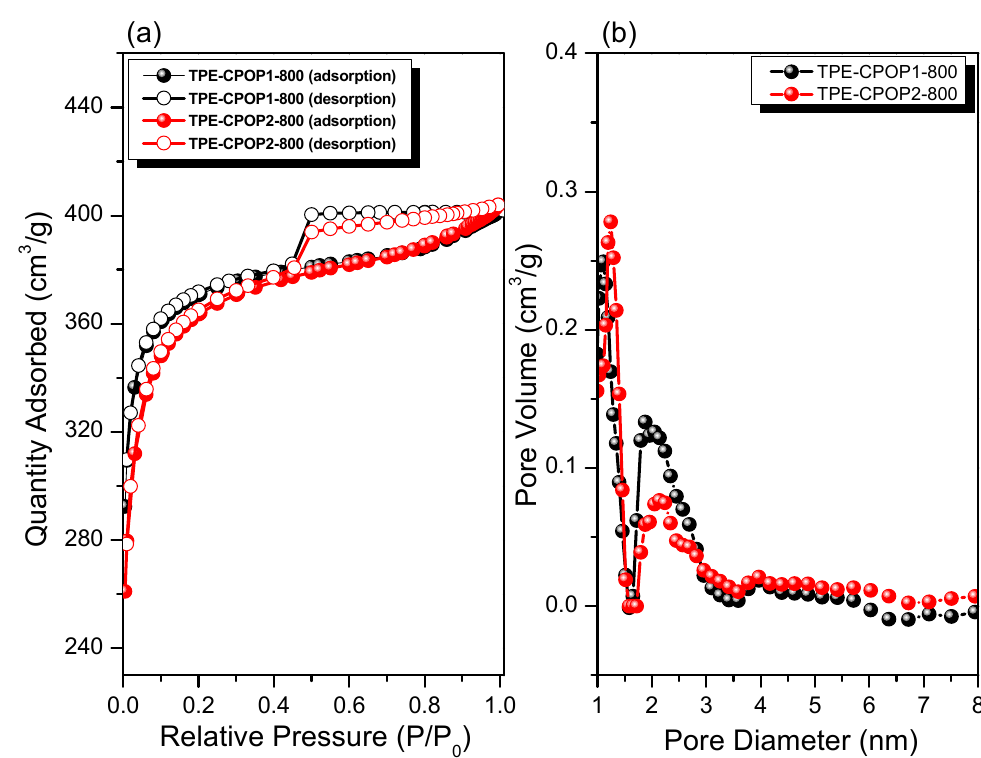
Figure 6. ( a ) N 2 adsorption desorption pattern (filled cycles: adsorption; empty cycles: desorption) and ( b ) pore size diameter of TPE-CPOP1-800 and TPE-CPOP2-800.